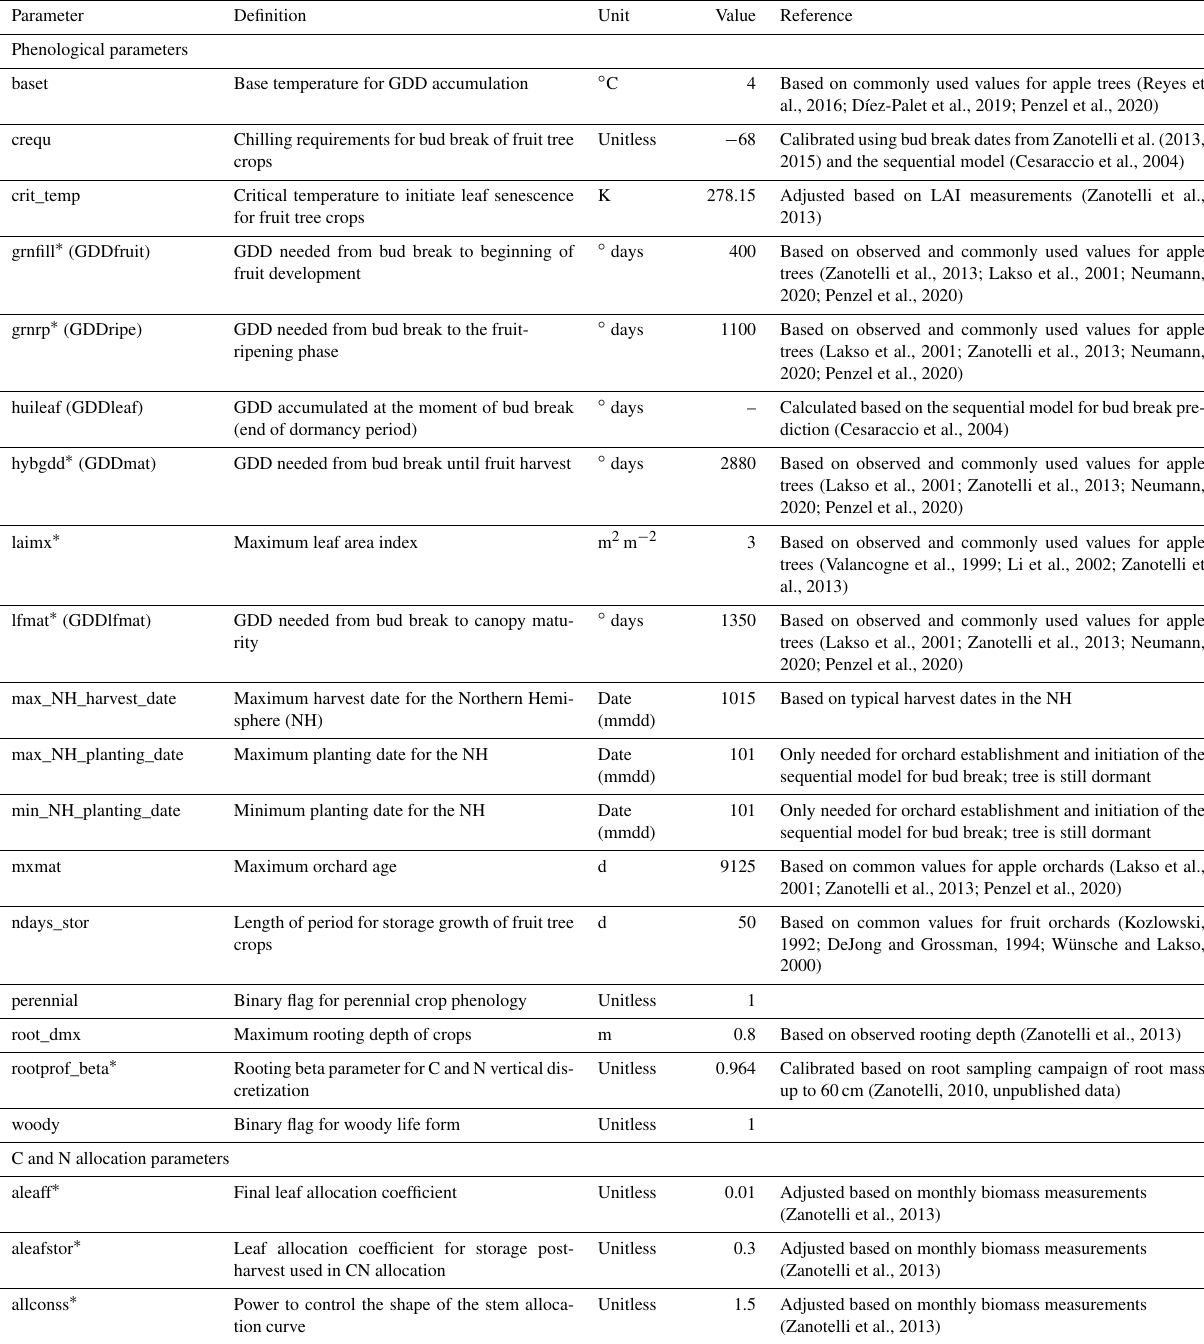
Table C1. Parameters adapted or added in the new CLM5-FruitTree sub-model and the apple PFT, including phenology, CN allocation, photosynthesis, vegetation structure, as well as optical and respiration parameters. Parameters were adjusted based on field observations or literature values and are listed with their definition, unit, value, and references to the